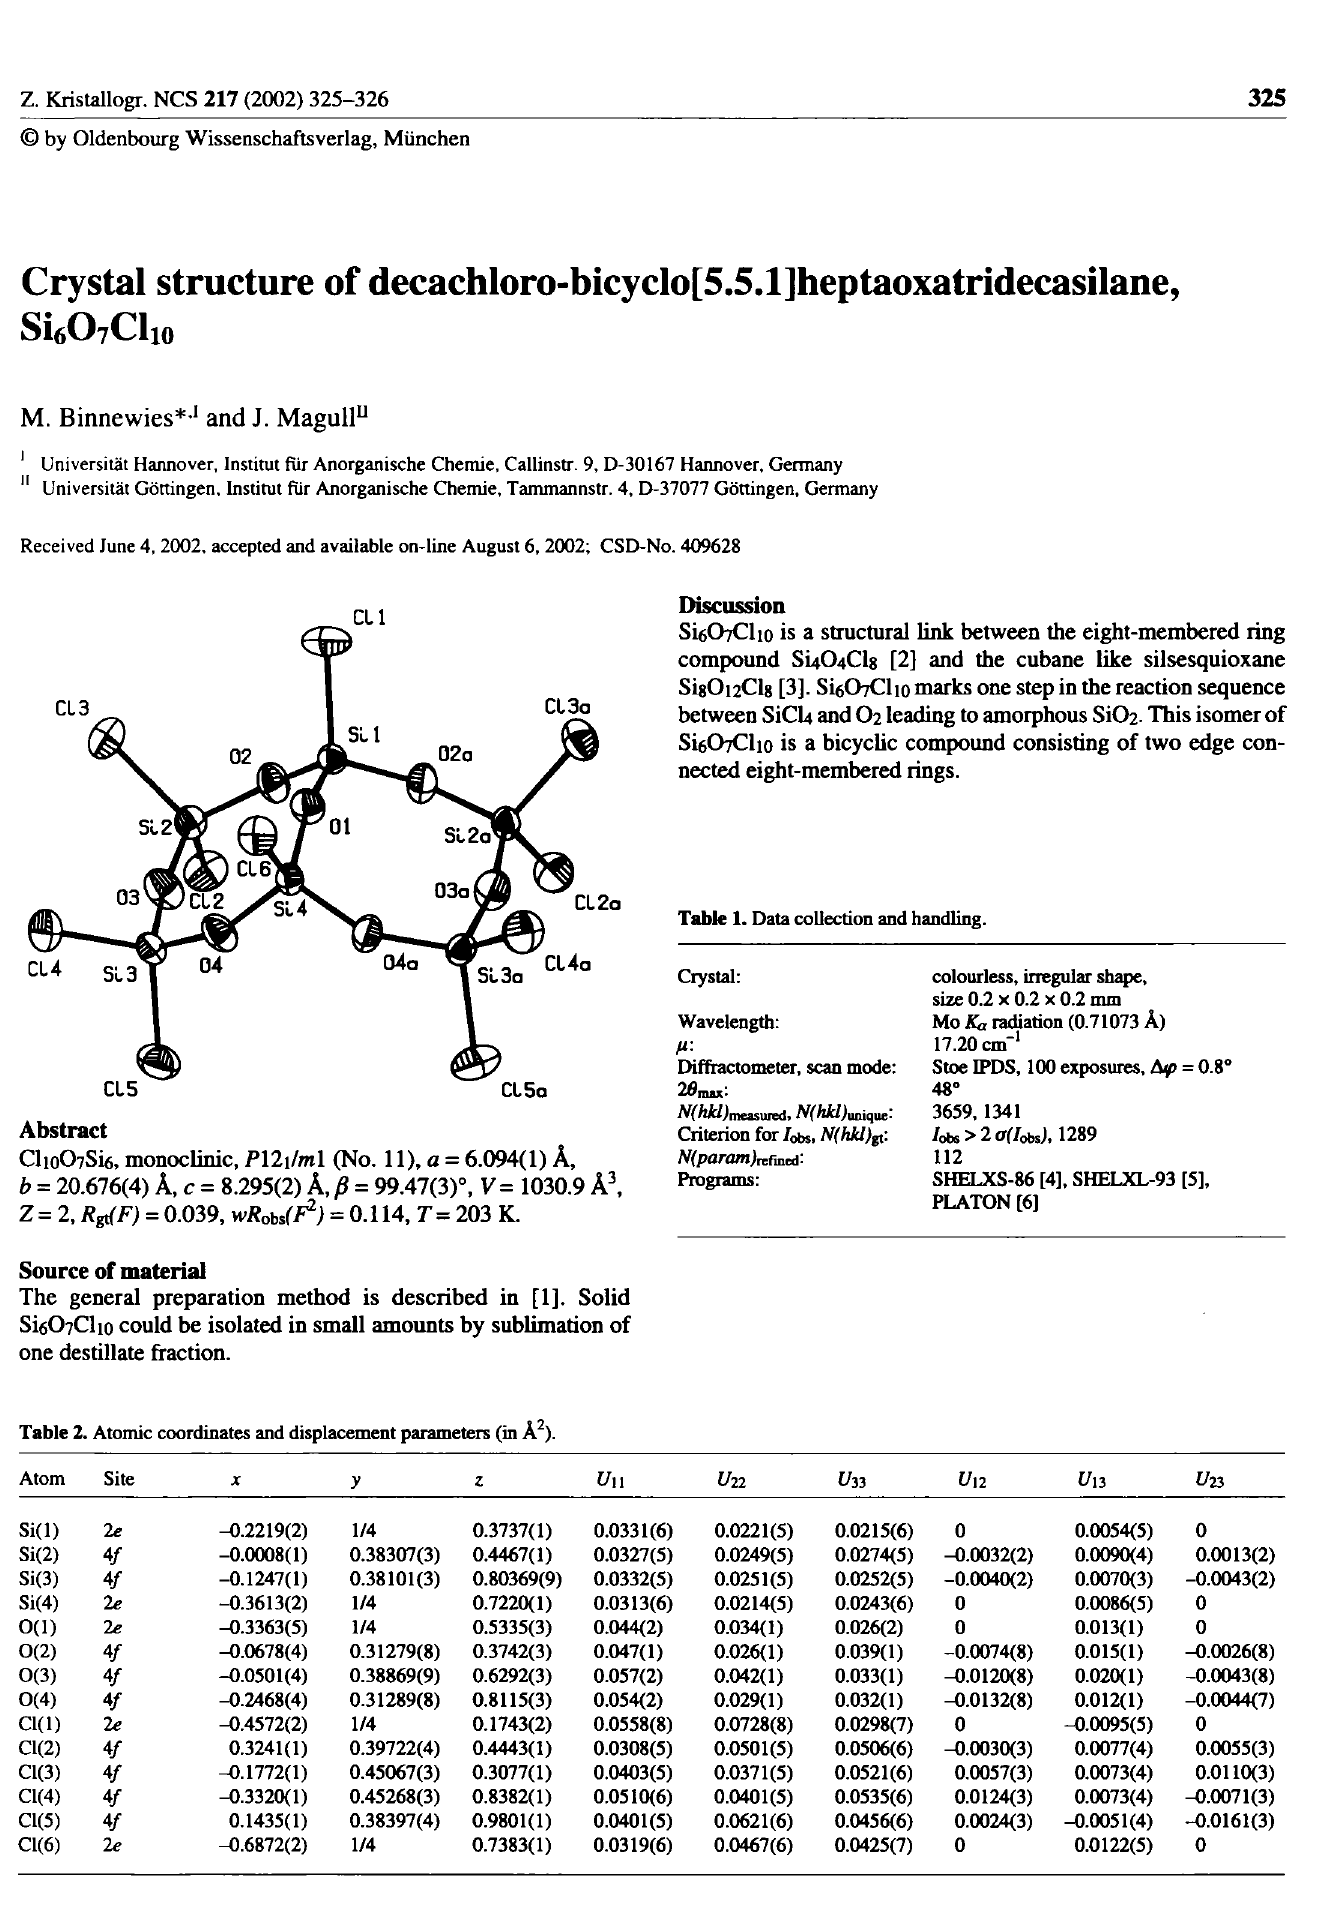
Table 2. Atomic coordinates and displacement parameters (in Â 2